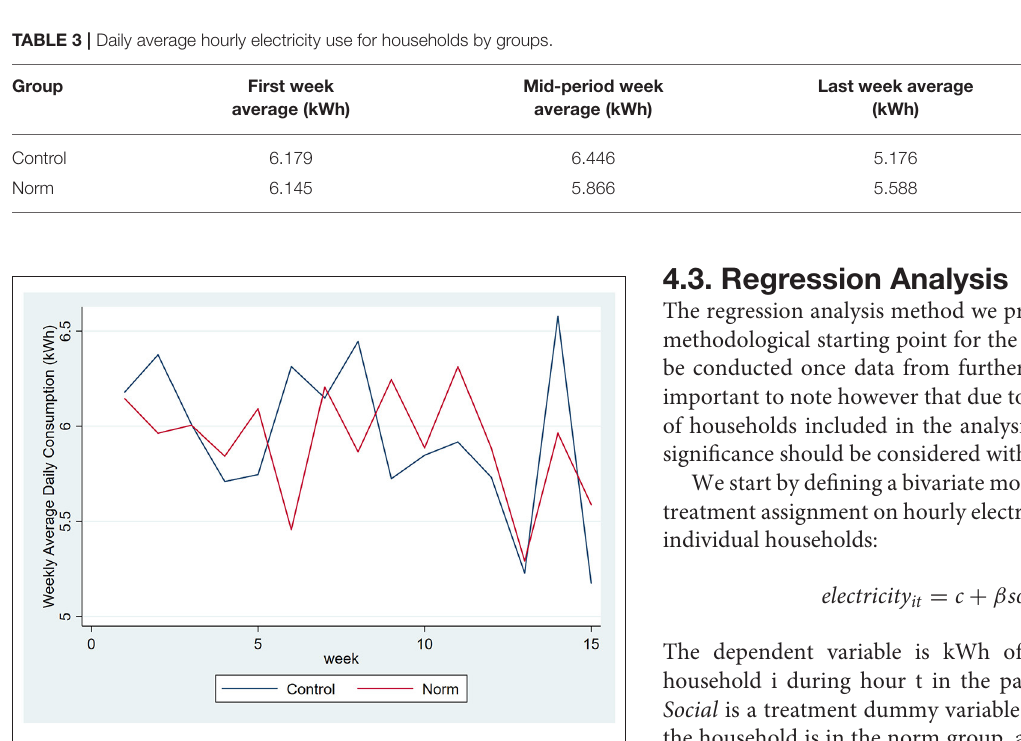
groups. The variable of interest is weekly average daily electricity consumption 5